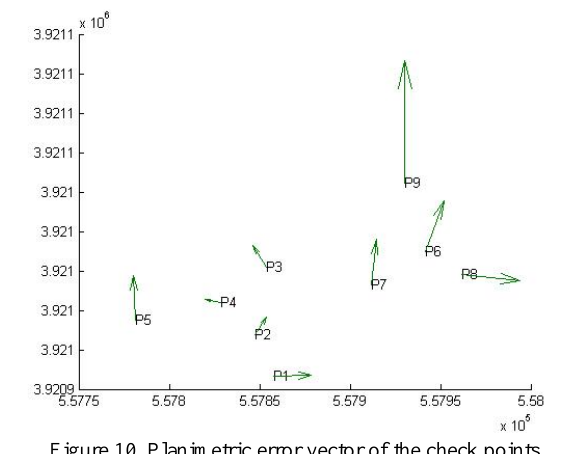
Figure 10. Planimetric error vector of the check points The obtained results show the comparable accuracy of ortho- photo generated based on thermal images with respect to visible ortho-photo. The statistical analysis on check points coordinates are shown in Table 3. Four statistical parameters are computed. These parameters are the minimum, maximum, MAE and RMSE of check point’s error in X, Y and Z directions. Table 3. Statistical assessment of check point accuracy